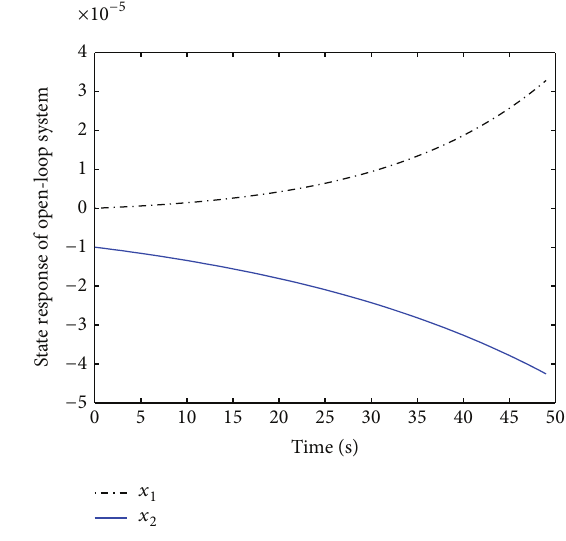
Figure 6: The state response of open-loop system.